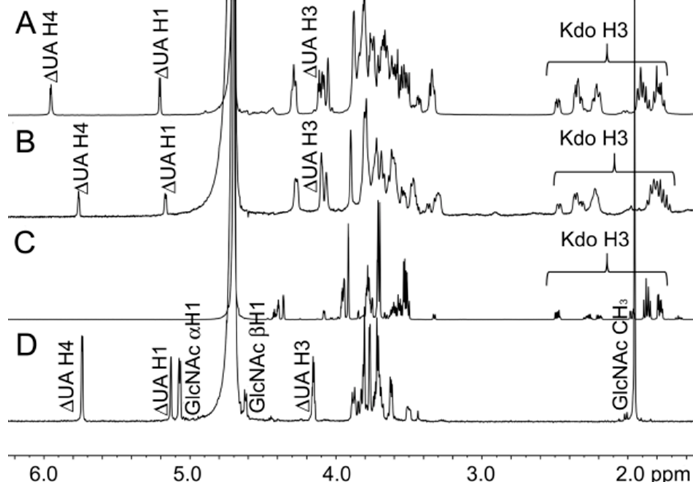
Figure 2. 1 H NMR spectrum of ( A ) resistant fraction 1, ( B ) resistant fraction 1’, ( C ) 3-deoxy- D - manno -oct-2-ulosonic acid (Kdo) standard, and ( D ) heparosan disaccharide ( Δ UA-GlcNAc) standard. The Δ UA H4 of resistant fraction 1 is impacted by residual digestion buffer calcium ions exhibiting a slightly different chemical shift from that of resistant fraction 1’ and Δ UA-GlcNAc standard.